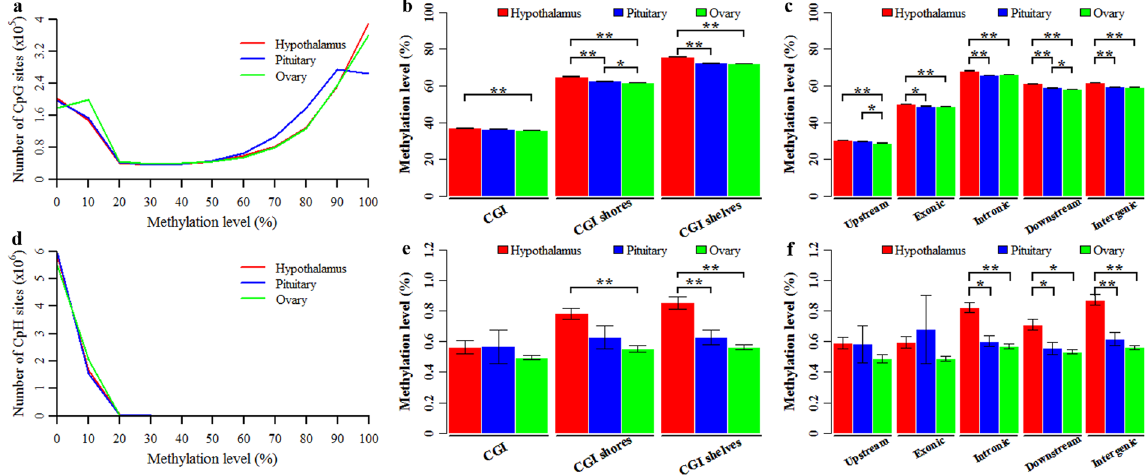
Figure 1. Genome-wide DNA methylation of porcine hypothalamus-pituitary-ovary tissues. Distribution of methylation levels in the CpG ( a ) and CpH ( d ) contexts. Mean methylation levels of CpGs in CGI-related regions ( b ) and gene-related regions ( c ). Mean methylation levels of CpHs in CGI-related regions ( e ) and gene- related regions ( f ). * Denotes p-value < 0.05, ** denotes p-value <